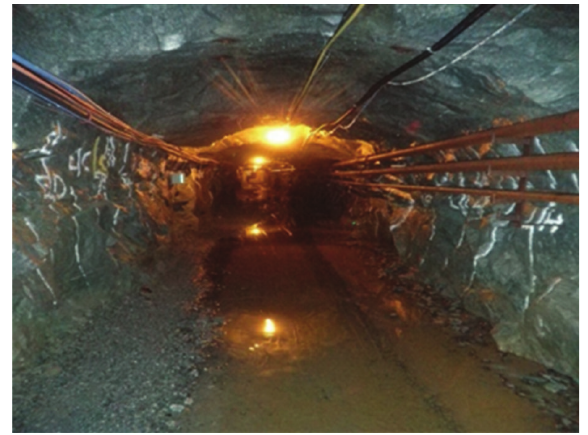
Figure 2: Photography of a gallery in CANMET mine at level